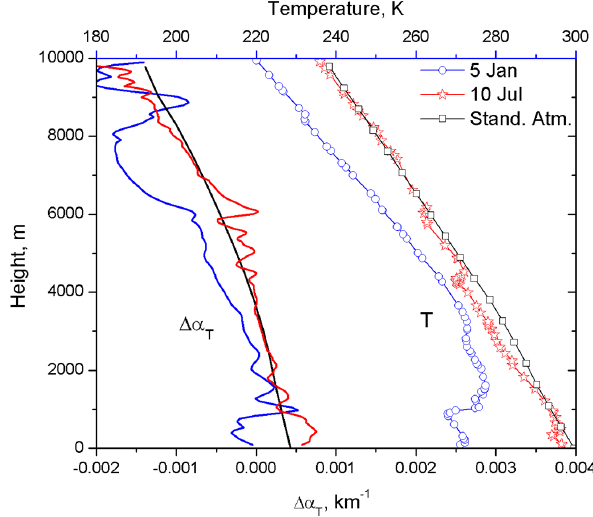
Figure 5. Vertical profile of X computed on the basis of the US Standard Atmosphere model for the interference filter used. The ref- erence height is taken at z 0 = 0; the open symbols mark the model temperature profile.